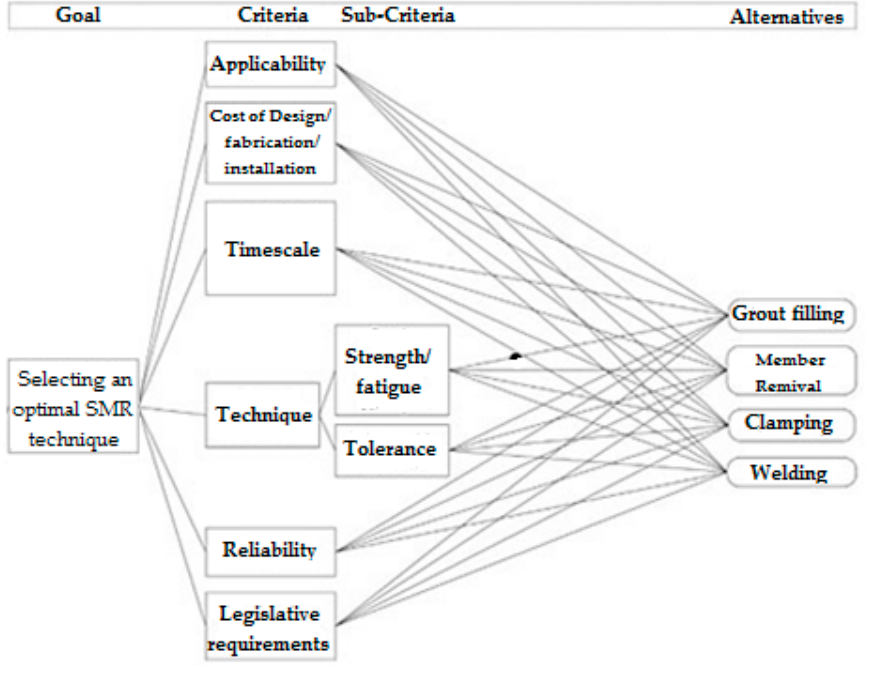
A comparison has also been made between a tuned mass damper (TMD) and semi- active tuned mass damper (SATMD), in which the activity is controlled by a fuzzy logic controller (FLC) under various natural factors, such as water waves, sea currents, wind, and earthquake. From Figure 8, SATMD has a greater ability to reduce lateral displace- ment, velocity, acceleration, base shear, and overturning moment [39]. Figure 7. The structure of the analytical hierarchy process for selecting SMR techniques [37].